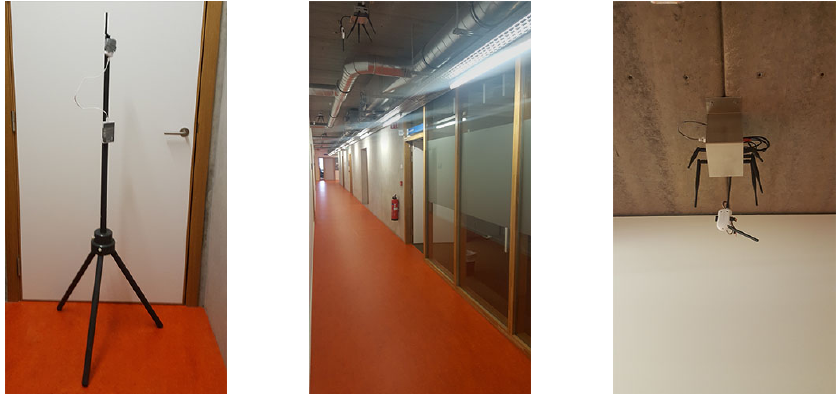
Figure 3. Tripod with battery powered mobile node and ceiling mounted fixed access points in